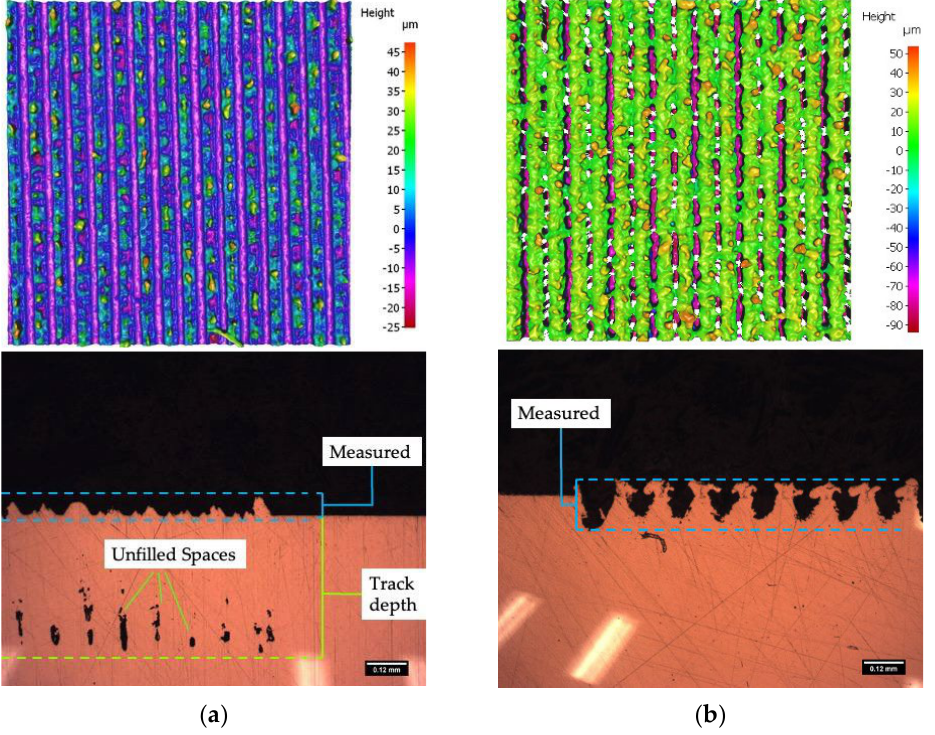
Figure 5. Surface mapping and cross section: ( a ) Ed = 35.37 J/cm 2 and Vs = 10 mm/s; ( b ) Ed = 35.37 J/cm 2 and Vs = 50 mm/s.